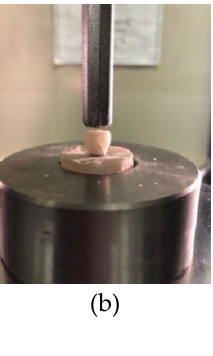
(d) Figure 3. Fractures of the four tested groups on the titanium abutment: (a ) Group A: porcelain fused to metal; ( b ) Group B: monolithic zirconia; ( c ) Group C: zirconia coping with a ceramic ve- neer; ( d ) Group D: full contour all-ceramic lithium disilicate. (a)